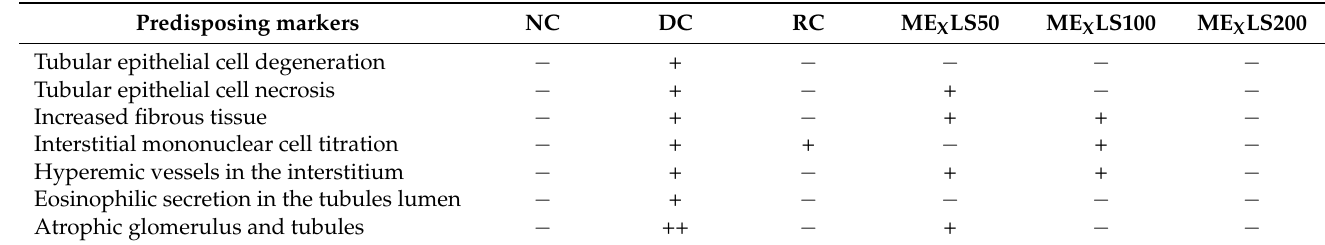
Figure 6. Image of the kidney tissues from the experimental animal groups as seen through histopathology. The glomerulus of a kidney cell is seen in the image (microscopic resolution: 10 × 40). Hematoxylin and eosin-stained rat kidney micrographs. The images displayed are the glomerulus slices counterstained with hematoxylin and stained with PAS. Arrow signs indicate the point of recovery from necrosis. Table 6. Scoring for the effect of ME X LS on the architectures of kidney tissues.